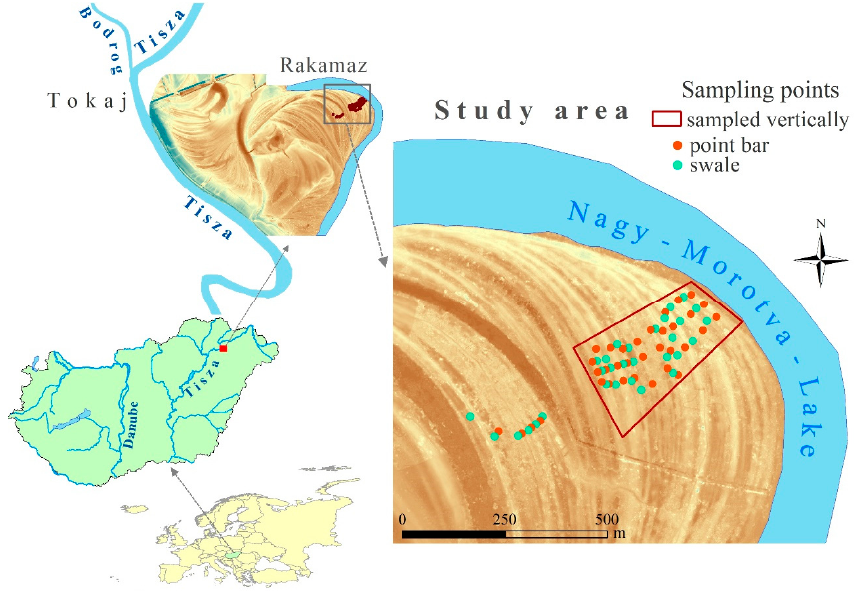
Figure 1. The location of the study area and the points of the soil sampling (the background is a LiDAR-based digital terrain model).